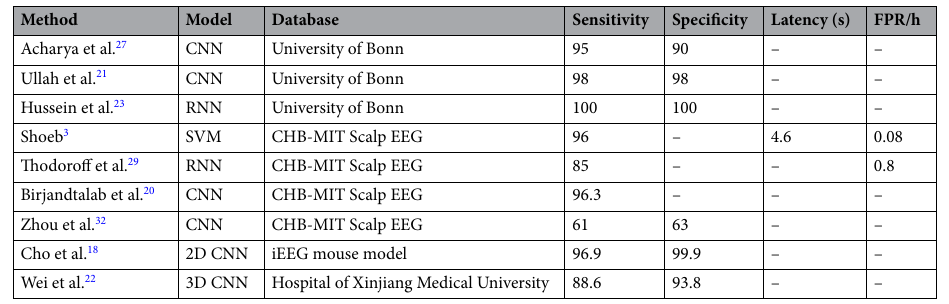
Table 1. Performance comparison of recent seizure detection studies with automated